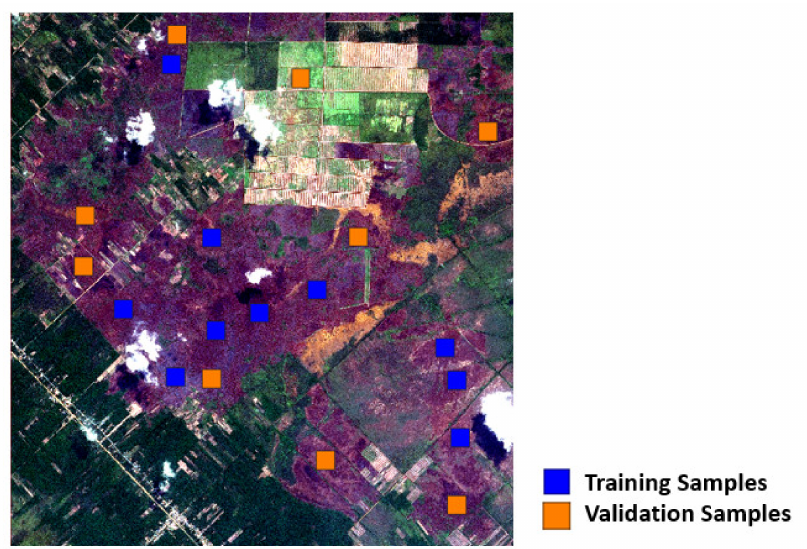
Figure 7. Selected training and validation sample locations.